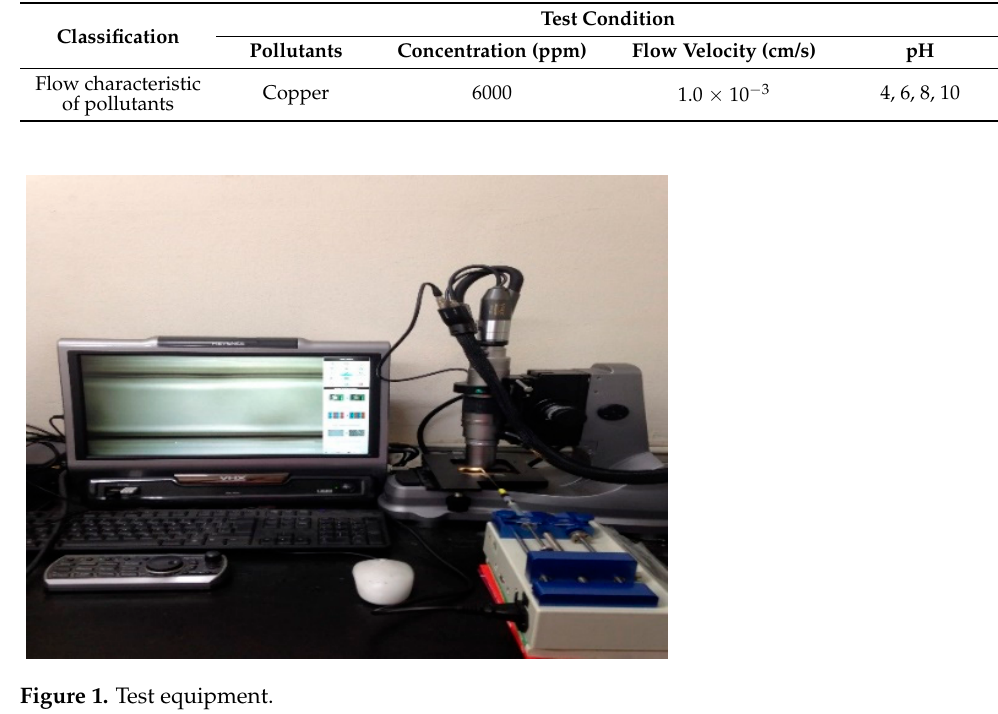
Table 1. Microfluidic Flow Test Condition.